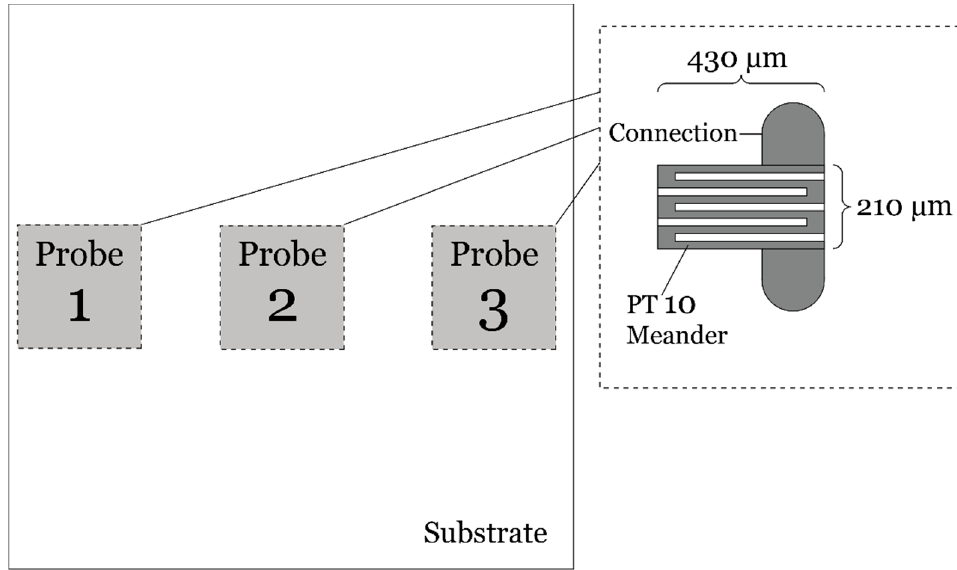
Figure 7. Detailed dimensions in x–y plane.